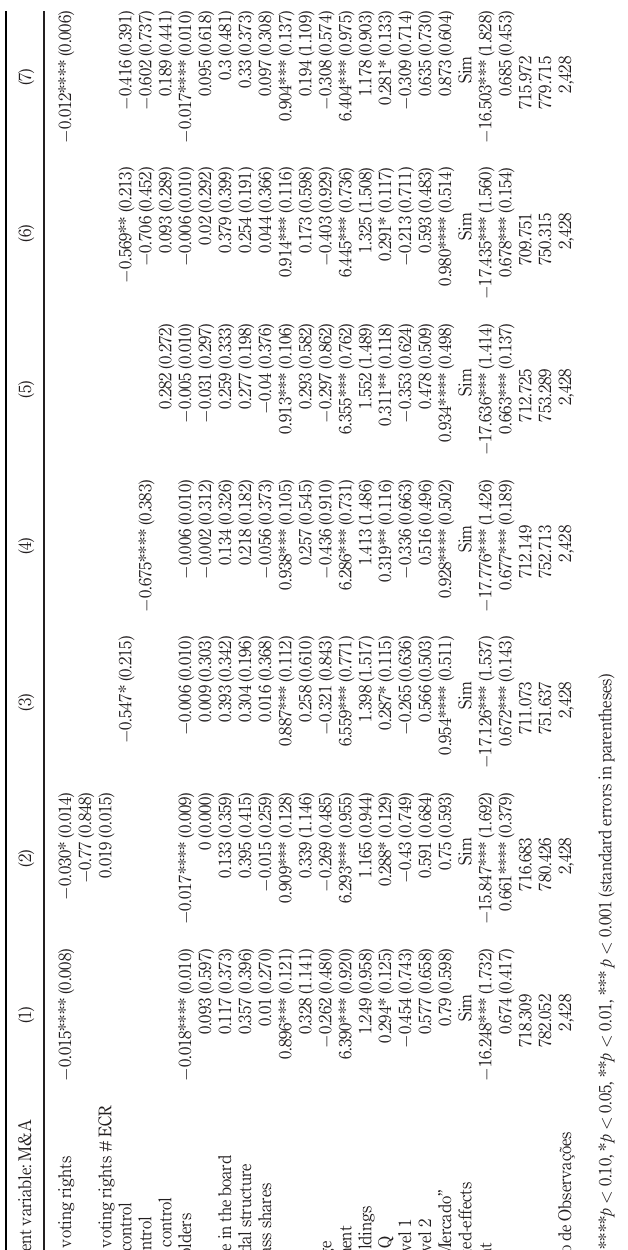
Table IV. Empirical